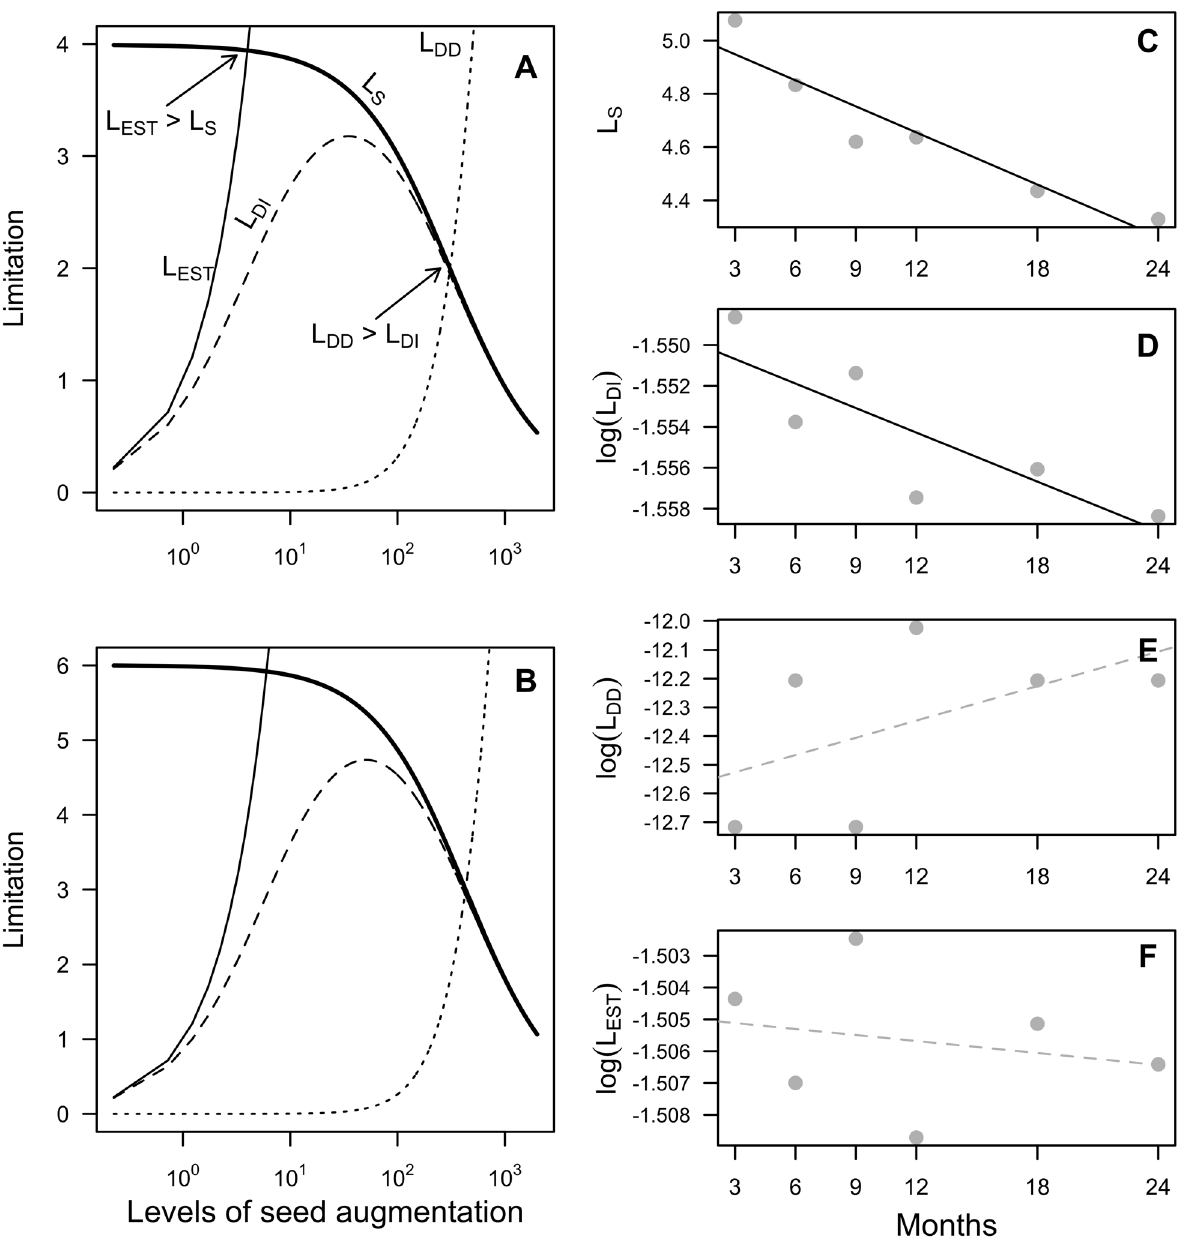
Figure 3. Results of limitation analysis for all species combined. Results are presented for (A) three months and (B) 24 months after seed augmentation. Lines are establishment limitation (L E ), seed limitation (L S ), density-dependent mortality (L DD ), and density-independent mortality (L DI ). L E . L S represents the crossover point at which establishment limitation more strongly limits recruitment than seed limitation. L DD . L DI is the point at which density-dependence more strongly limits recruitment than density-independent mechanisms of mortality. The importance of fundamental seed limitation exceeds that of fundamental establishment limitation only at very low seed densities, with crossover points occurring at 4.2 (3 months) and 6.2 (24 months) times ambient seed conditions. These values are well within the range of natural seed rain densities observed across this study site (Table 1). Density-independent mechanisms of seedling mortality more strongly contribute to establishment limitation than do density- dependent mechanisms of mortality until seed densities reach approximately 309 (3 months) and 432 (2 years) times the average ambient seed densities. These values roughly mimic seed densities under parent trees but exceed the observed seed rain densities for most species, thus density- independent factors limit seedling recruitment at most ‘‘natural’’ seed densities whereas density-dependent mechanisms likely control seedling population size at the very high seed densities observed under fruiting canopies. Panels (C–F) depict the correlation of each of the types of limitation over time: black full lines represent a statistically significant correlation; whereas grey dashed lines depict lack of a statistically significant correlation. doi:10.1371/journal.pone.0063330.g003 environmental gradients. Stated differently, it matters where seeds germination and early recruitment (e.g., [34]). In our study system arrive: variation in abiotic factors (e.g., soils, nutrients, sunlight) these mortality factors reduced early recruitment to 17% of all and biotic factors (e.g., seed and seedling predation) limit rates of arrived seeds. Once a seedling is established, post-dispersal